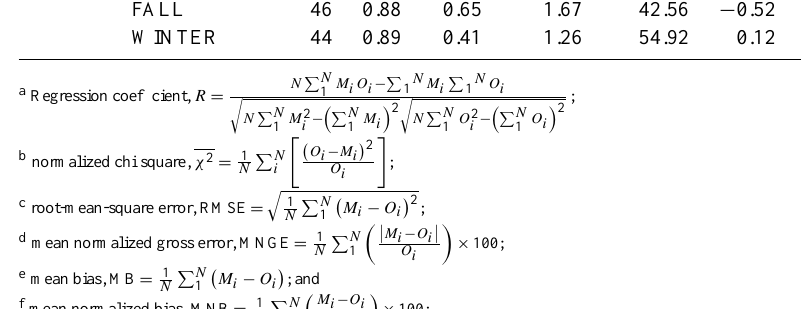
2b Species Period Number R a χ RMSE c MNGE d MB e MNB f of data (% ) ( N